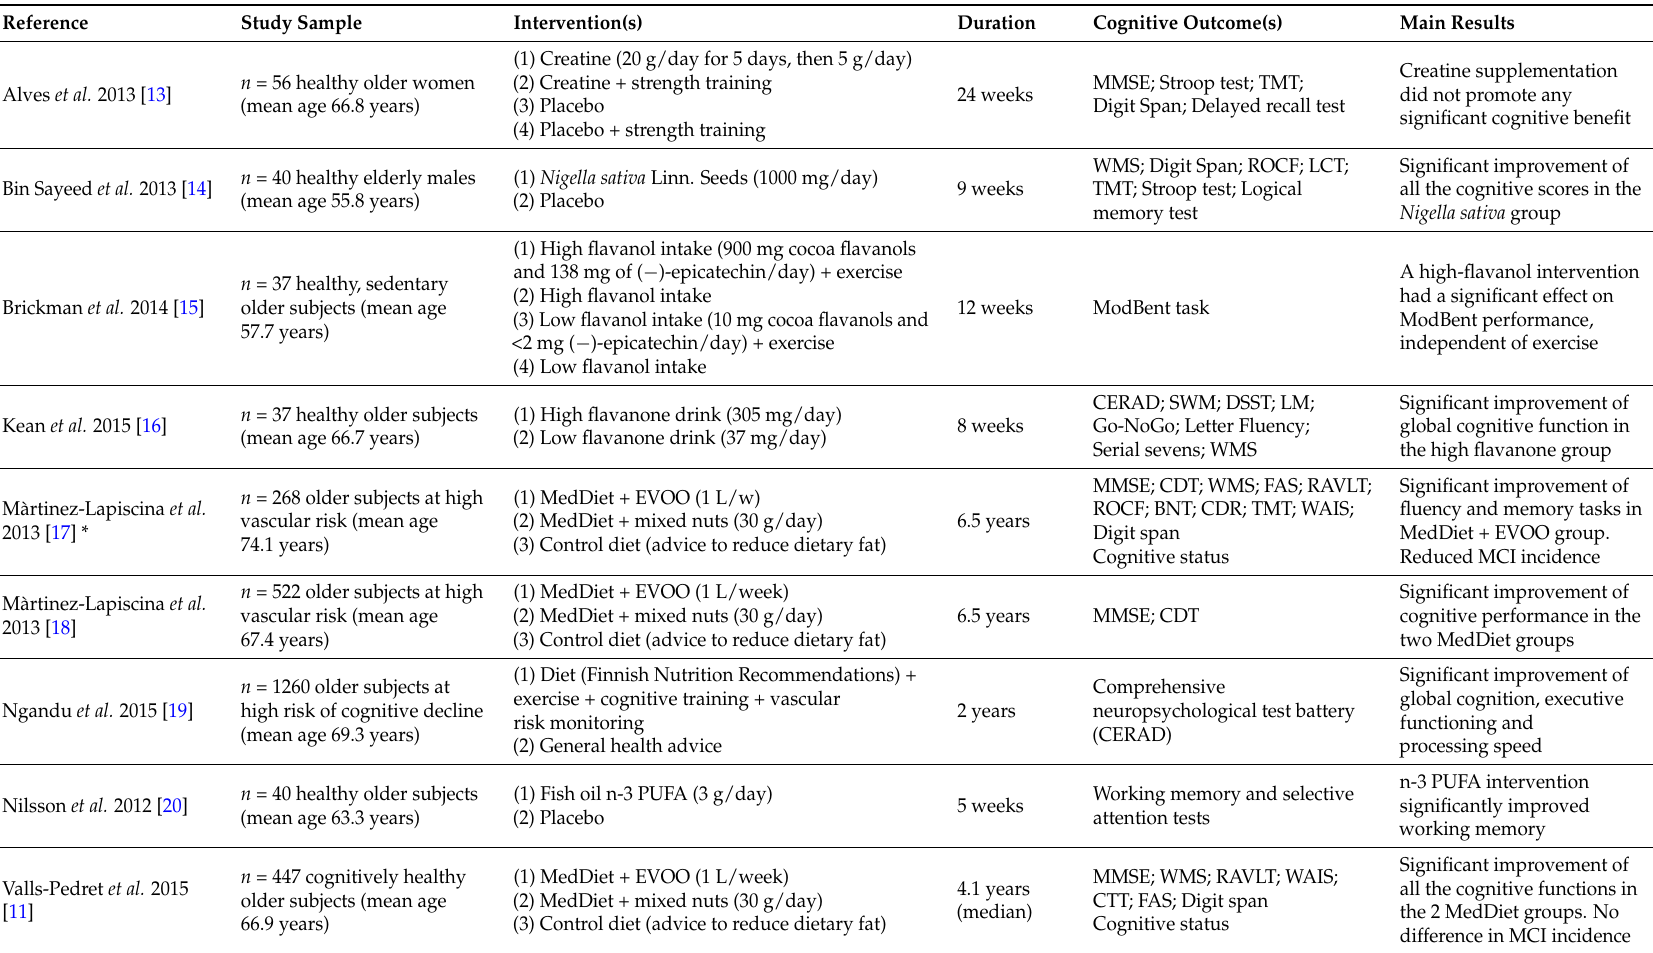
Table 1. Randomized controlled trials exploring the cognitive effects of nutritional interventions among non-demented older individuals published over the last 3